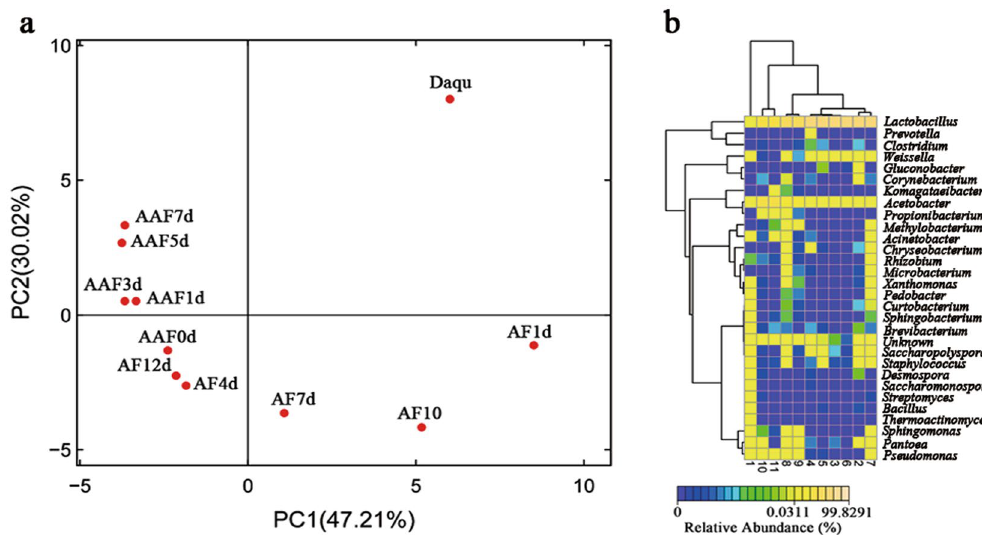
Figure 2. Principal component analysis (PCA) and hierarchical cluster analysis of bacterial community in the whole fermentation of SAV. ( a ) PCA score plot of 11 specimens based on metagenomes. The first two principal components (PC1 and PC2) can explain 77.23% of the data variance. ( b ) Changes in relative abundances of the dominant bacteria in 11 specimens. The color bar represents different abundances. Daqu represents the daqu specimen, AF1d–AF12d represent specimens from 1 day to 12 days of alcohol fermentation, and AAF0d– AAF7d represent specimens from 0 day to 7 days of acetic acid